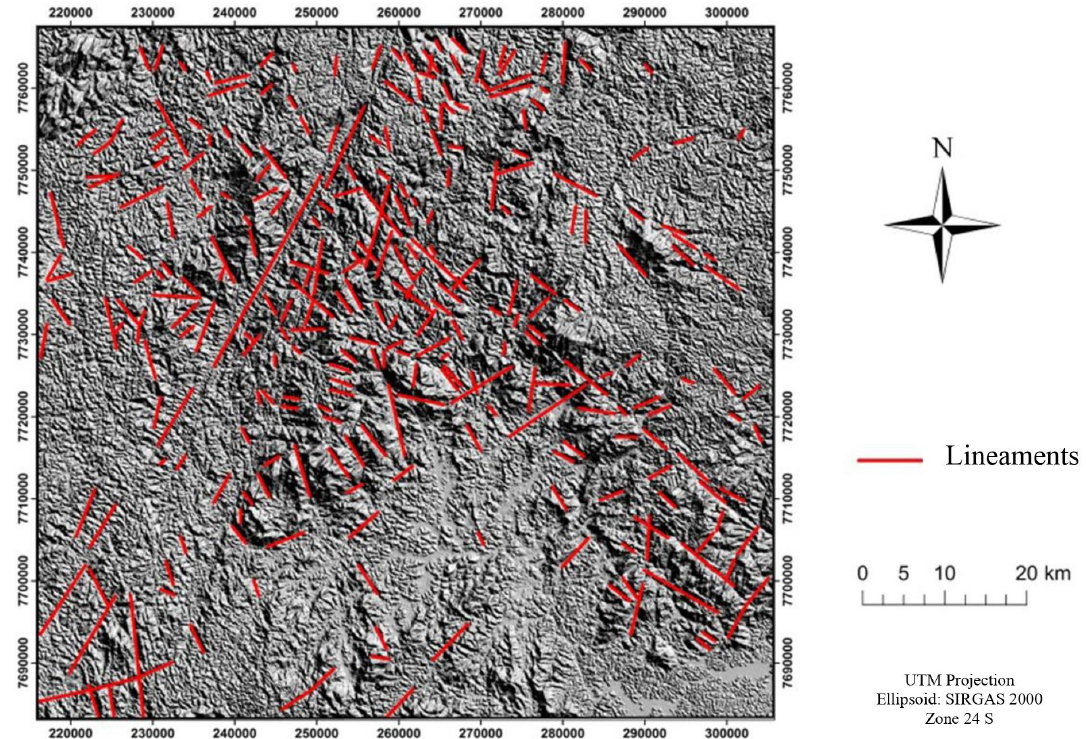
Figure 9. Directional maps of linears features automatically extracted by the LINE algorithm.